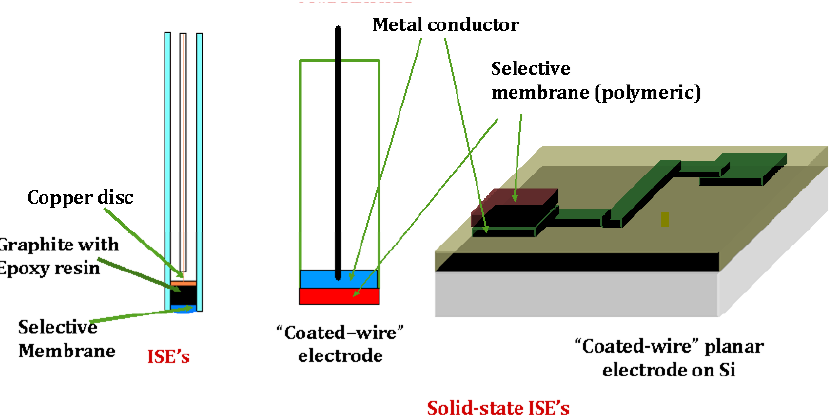
Figure 2. Schematic representation of solid ISEs ( left ) and the similar coated ‐ wire or Si wafer ( right ). Very relevant for this research on potentiometry based on closo ‐ borate anions was that all PVC membranes for potentiometric sensors were prepared in THF. Therefore, the ammonium salts of [3,3 ′‐ Co(1,2 ‐ C 2 B 9 H 11 ) 2 ] − and PVC had the same solubility requirements: very soluble in THF and insoluble in water. From the point of view of making the mem ‐ brane, it seemed that all factors were pointing in the same direction. If now we restrict to the θ cobaltabis(dicarbollide) [3,3 ′‐ Co(1,2 ‐ C 2 B 9 H 11 ) 2 ] − potentiometric electrodes and to make the construction simpler, even at the cost of having a lower limit of detection, LOD, we have moved away from the traditional electrode in which the membrane separated the solution with the analyte from an internal aqueous solution in which there was an inner reference electrode, see Figure 3 top. In 2006, the research addressed developing poly ‐ meric sensing membranes based on the principles of host ‐ guest chemistry, as they allowed the selectivity of the sensor to be modulated. Many hundreds of receptors have been de ‐ veloped for this purpose. Typically, there was a lipophilic ion exchanger in addition to the ionophore, which was the gateway for the ions to be measured to enter the membrane. Commonly tetraphenylborate had been used as an ion exchanger, but also the boron clus ‐ pose [31]. It was then considered that the emf response of such membranes was described librium across interfaces and does not consider changes in potential within the membrane